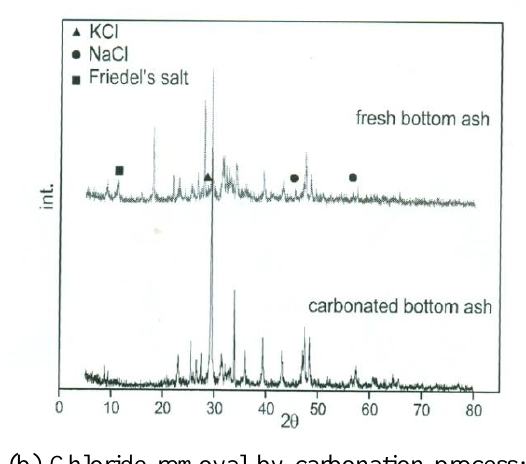
Figure 6. XRD patterns of the bottom ash from municipal solid waste incineration (MSWI) before and after washing (a) and carbonation (b) process (from Jo et al . [26] and Ahn et al . [24] with permission of KSGE ).